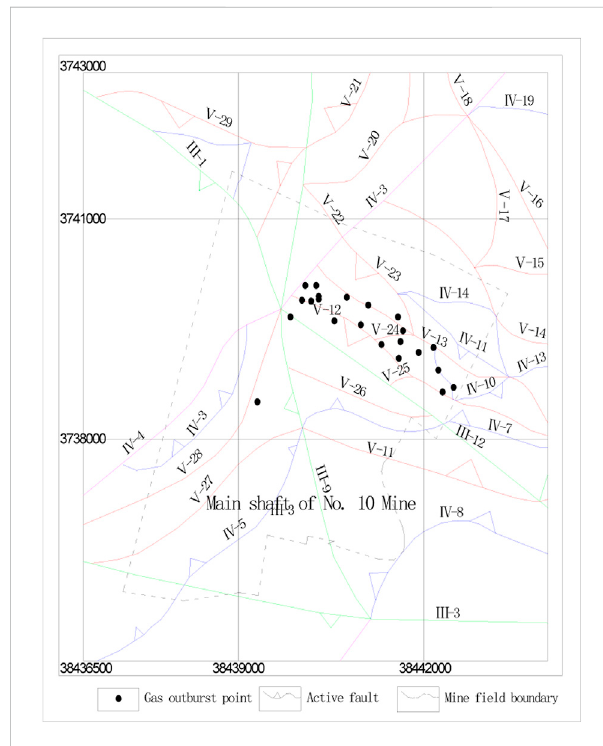
FIGURE 4 Grade VI fault map and spatial distribution map of coal and gas outburst in Pingdingshan No. 10 coal